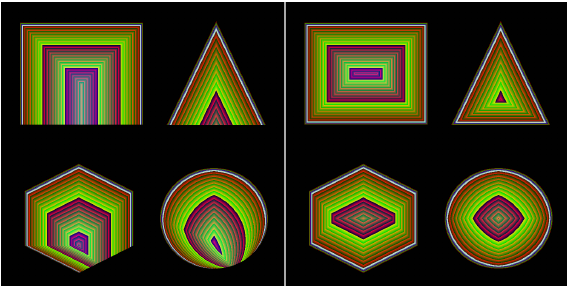
Figure 7. Result of the two steps of the FDT. Algorithm 1 FDT algorithm first step with the d 8